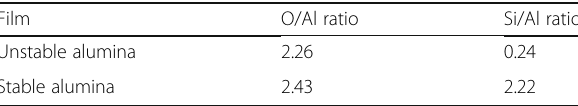
Table 1 Calculated O/Al and Si/Al ratios based on atomic percentages measured by